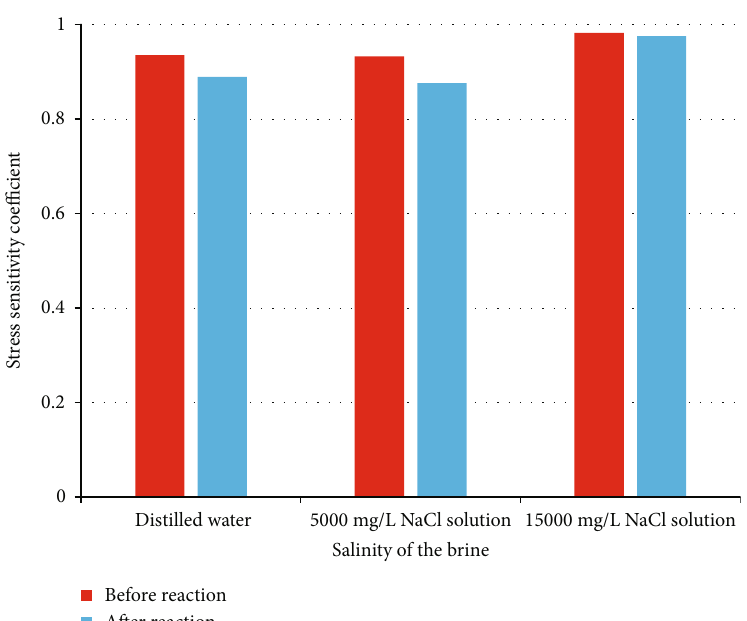
Figure 10: Stress sensitivity coe ffi cient of shale before and after interaction with di ff erent salinity of brine for 48 h.